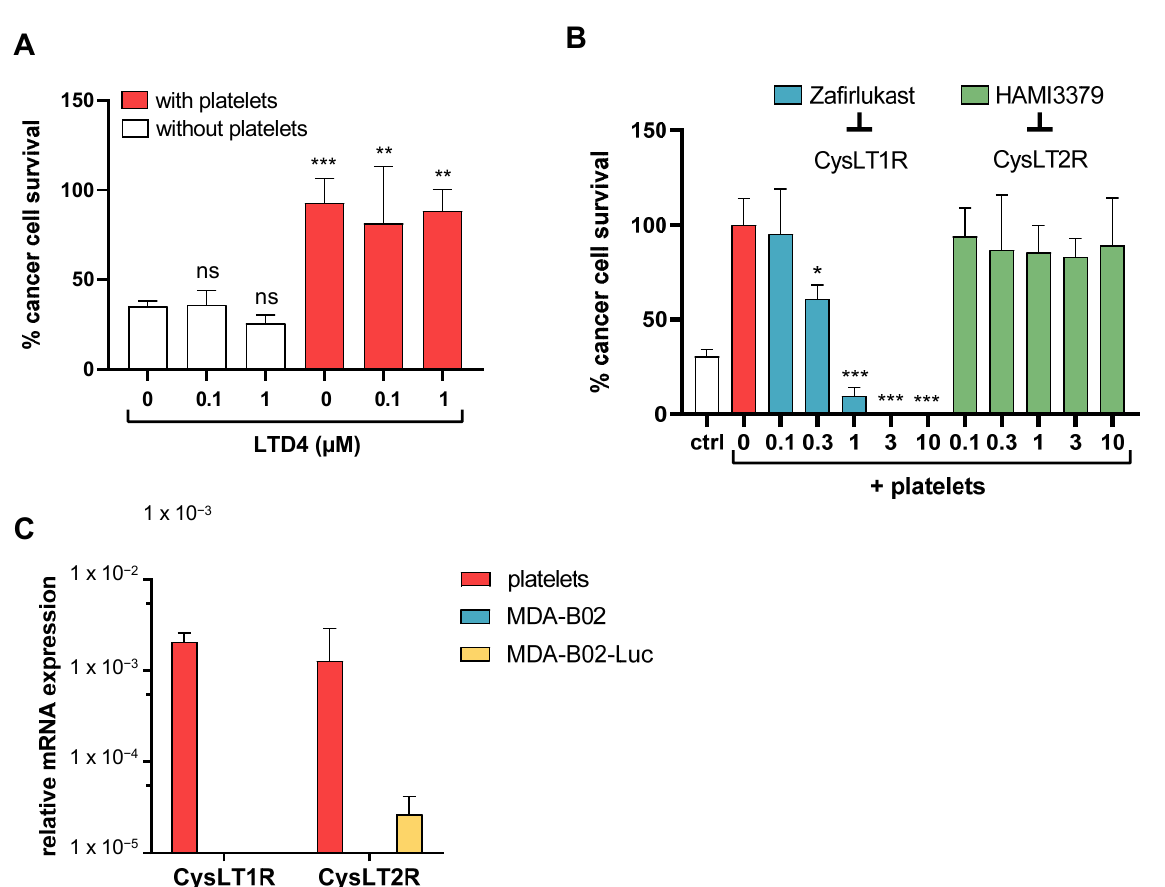
Figure 3. Cysteinyl leukotrienes promoting platelet-induced survival of human breast cancer cells exclusively via platelet–CysLT1 receptor. ( A ) Effect of LTD4 on MDA-B02-Luc cell survival in absence or presence of platelets (ns = not significant; ** p < 0.005; *** p < 0.001; vs. NT without platelets; one-way ANOVA). ( B ) Effect of zafirlukast, a CysLT1R antagonist, or HAMI 3379, a CysLT2R antagonist, on platelet-induced MDA-B02-Luc cell survival. All concentrations are in µM (* p < 0.05; *** p < 0.001; vs. NT; one-way ANOVA). ( C ) RT-qPCR analysis of CysLT receptors in human platelets or MDA-B02 cancer cells. Human platelets come from three different donors.